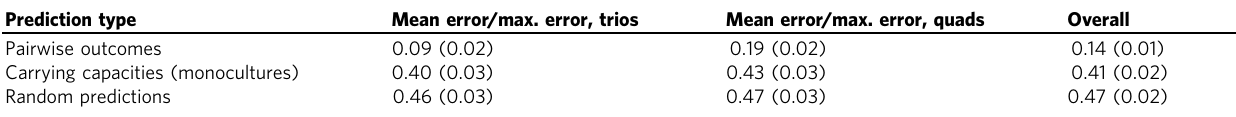
Table 1 Errors of pairwise assembly rules are much lower than monoculture prediction errors Prediction type Mean error/max. error, trios Mean error/max. error, quads Pairwise outcomes